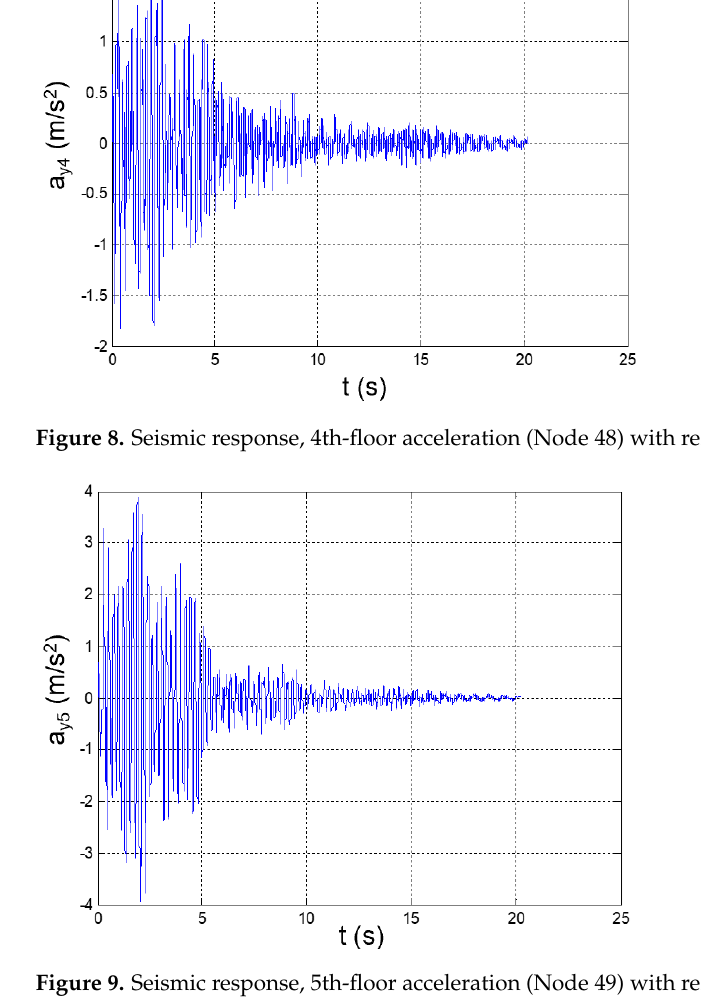
Figure 9. Seismic response, 5th-floor acceleration (Node 49) with respect to the ground.